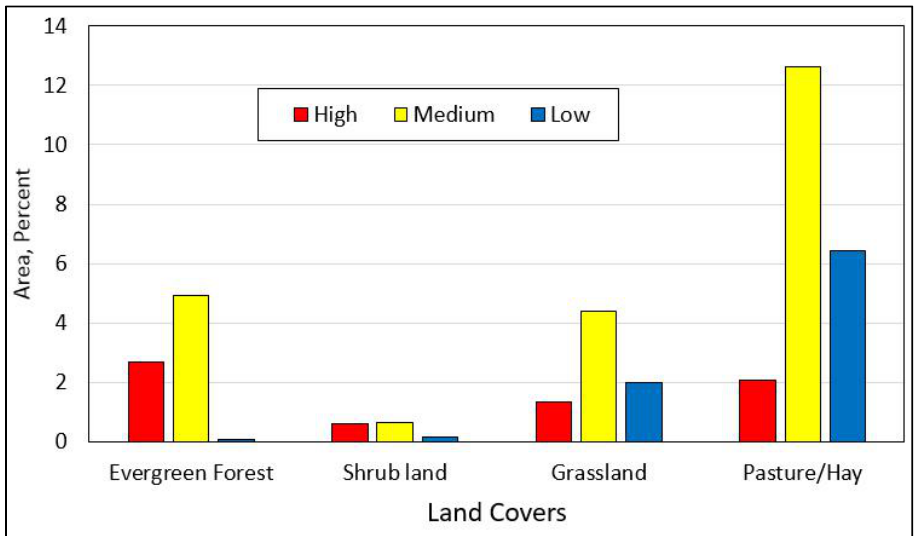
Figure 5. Site Suitability distribution for loblolly pine under selected land uses (evergreen forest, shrubland, grassland, and pasture/hay).